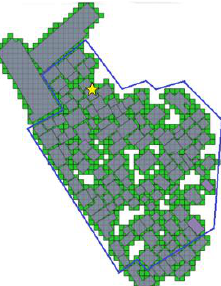
Figure 1. Tamiya Mapping of Buildings to Cells In Figure 1, each box represents a building footprint while the blue polygon represents the extent for fire in the area. The star indicates the origin of fire. The grid cells are represented as green cells in the